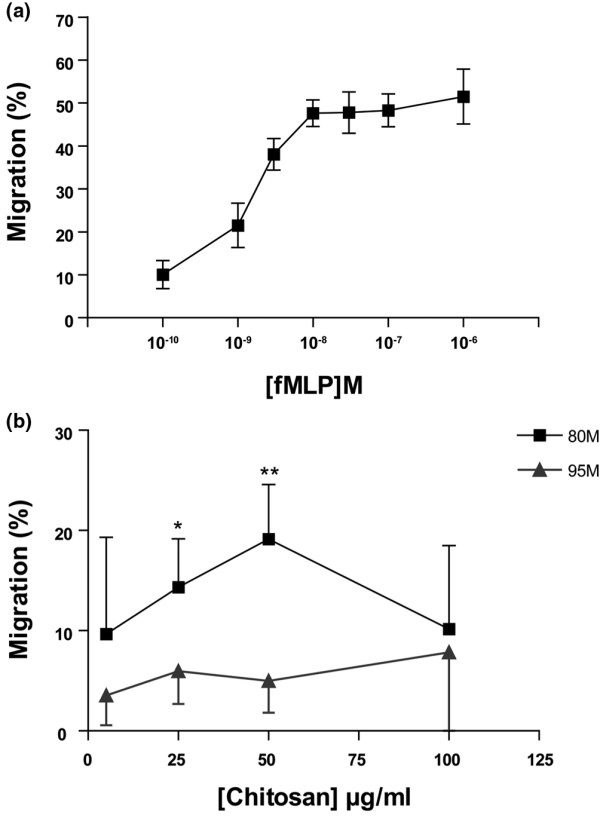
The chemotactic effect of chitosan on PMNs. Freshly isolated polymorphonuclear neutrophils (PMNs) were pre-stained with 1 μg/ml calcein-AM and seeded on a polycarbonate filter placed above a well containing (a) N-formyl-methionyl-leucyl-phenylalanine (fMLP; positive control) or (b) 80% deacetylated (80 M; black line) or 95% deacetylated (95 M; gray line) chitosan. PMNs were allowed to migrate for 1 hour before assessing migration, as described in 'Materials and Methods'. Percentage migration of PMNs = the fluorescence of migrated PMNs/fluorescence of 20,000 PMNs/ml × 100, obtained from the standard curve. Results are presented as mean ± standard error. P values from Student's two-tailed unpaired t-test: *P = 0.01, fluorescence of PMNs migrated toward 25 μg/ml 80 M chitosan versus fluorescence of PMNs migrated toward RPMI (Ctrl-); **P = 0.004, fluorescence of PMNs migrated toward 50 μg/ml 80 M chitosan versus fluorescence of PMNs migrated toward RPMI. The positive control is the fMLP curve. This figure represents the results of three independent experiments.